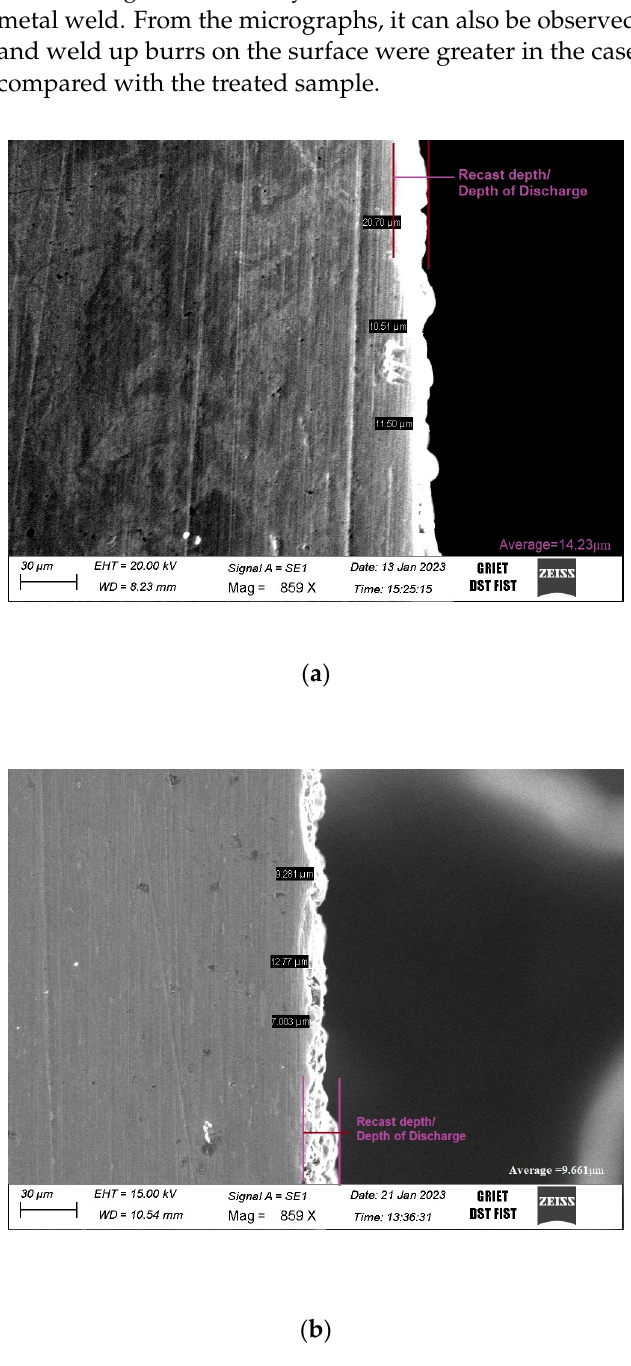
Figure 3. Micrographs of the machined surfaces of the ( a ) untreated and ( b ) cryogenically treated electrodes.